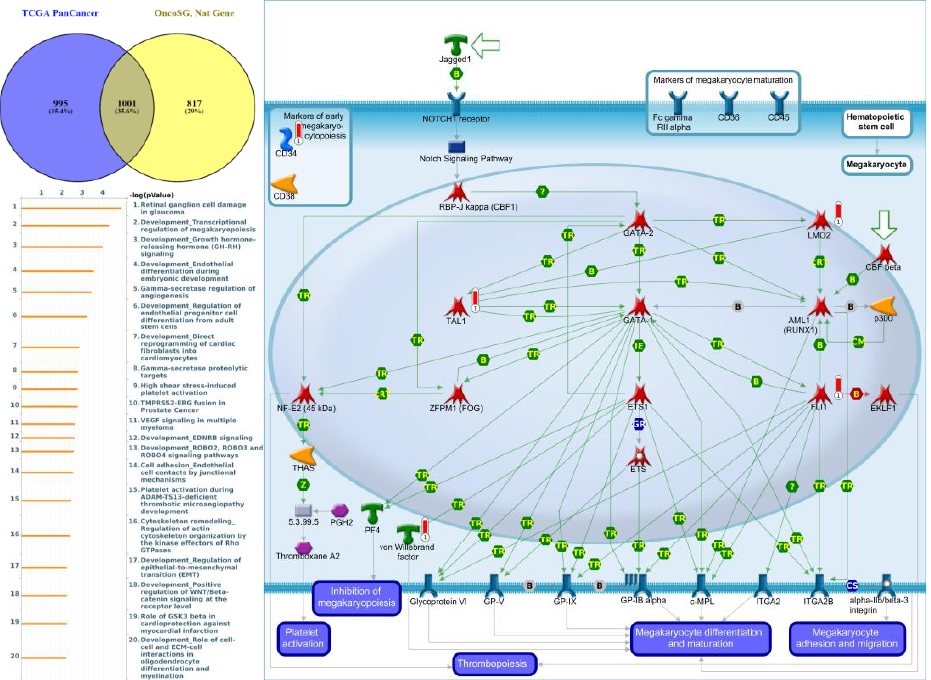
Figure 8. Expression of the protein tyrosine phosphatase non-receptor type 5 (PTPN5) signaling pathway in lung cancer (from Metacore). The functional analysis of “Development_Transcriptional regulation of megakaryopoiesis” was correlated with lung cancer development .